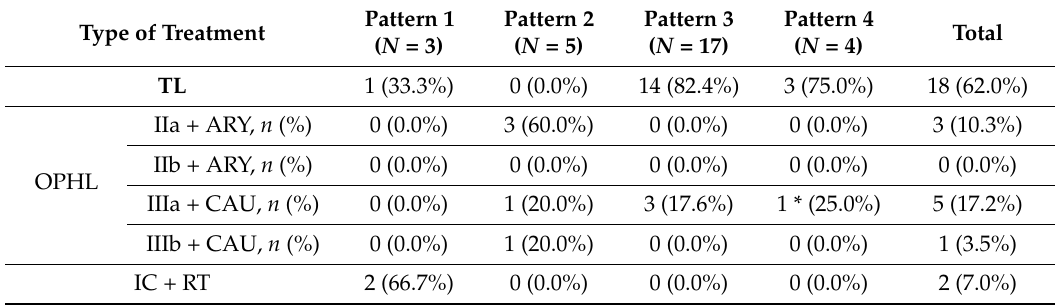
Table 2. Treatments performed in the 29 patients included in this